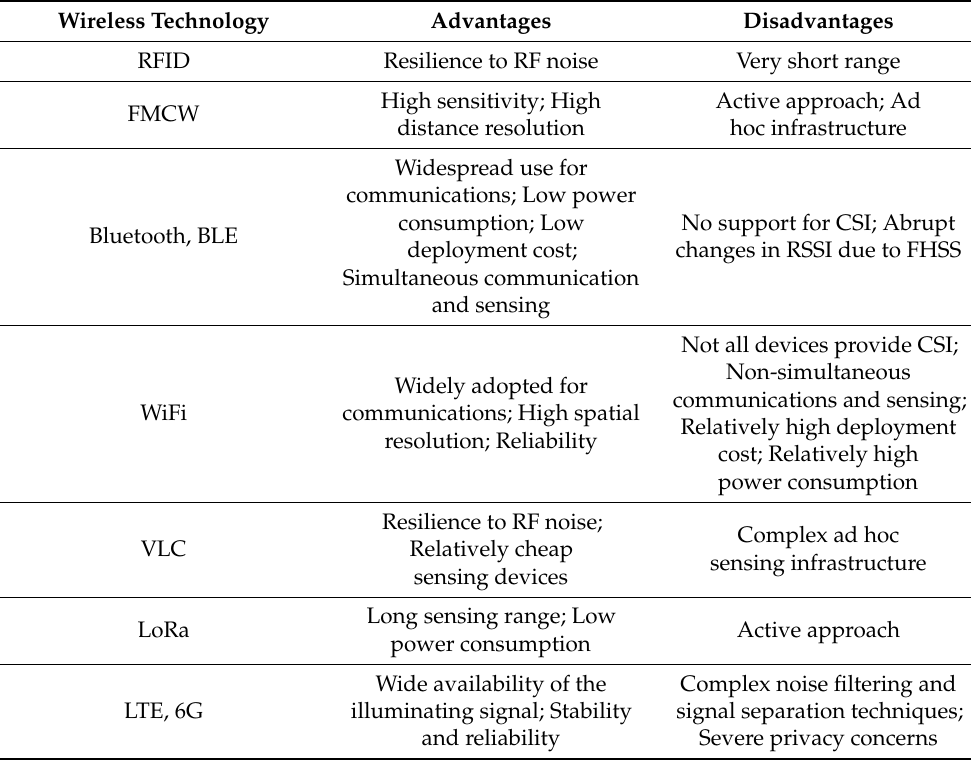
Table 1. Pros and cons of the most relevant applications of wireless communication technologies to wireless remote human sensing, as reported in the literature. Wireless Technology